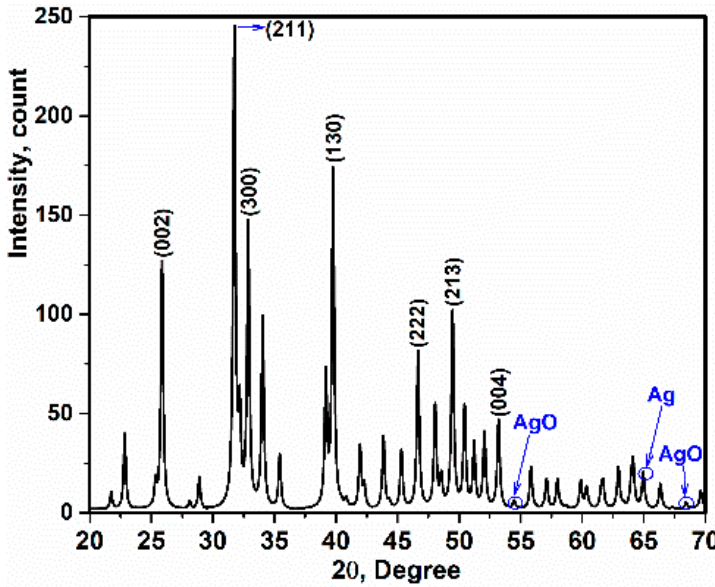
Figure 6. X-ray diffraction of Ag-doped HA+PVTMS scaffold.